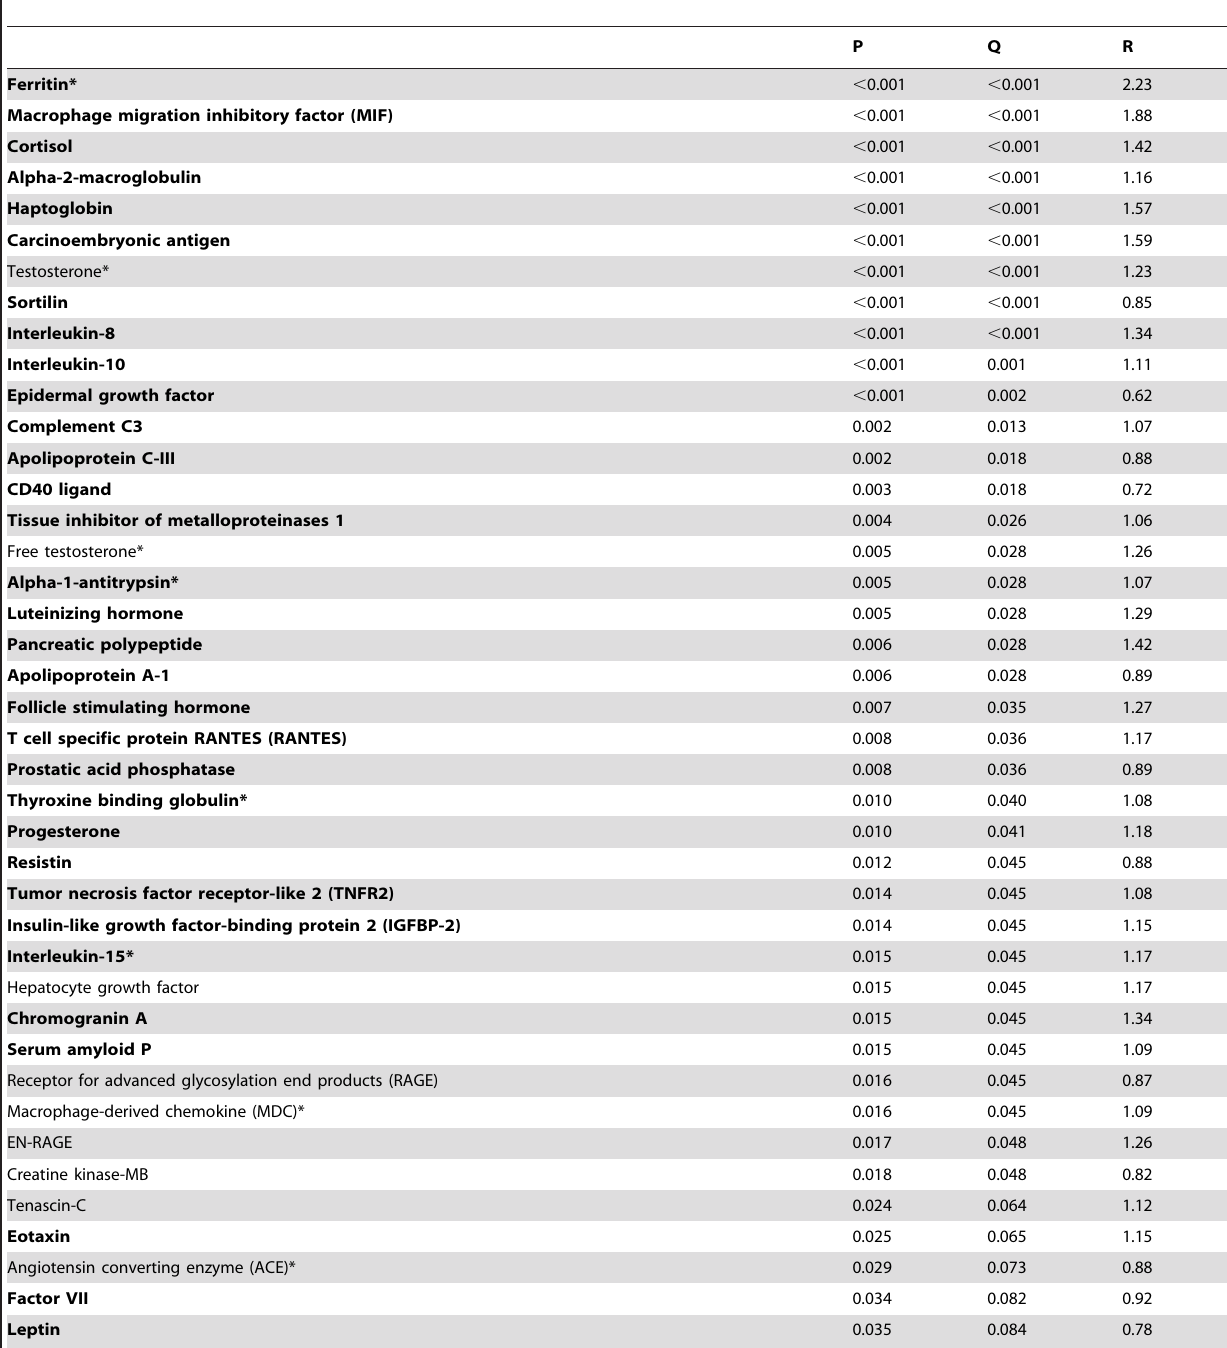
Table 3. Multiplex immunoassay profiling analysis of schizophrenia and control samples across the combined